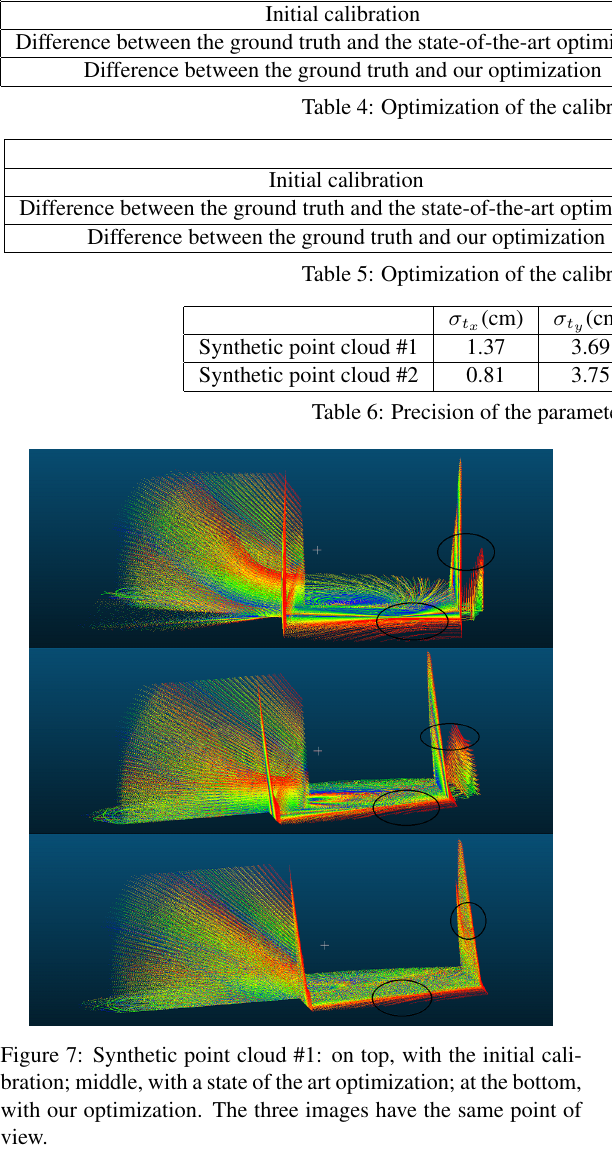
Figure 8: Synthetic point cloud #2: on top, before optimization of the calibration; middle, with a state of the art optimization; at the bottom, after our optimization. The three images have the same point of